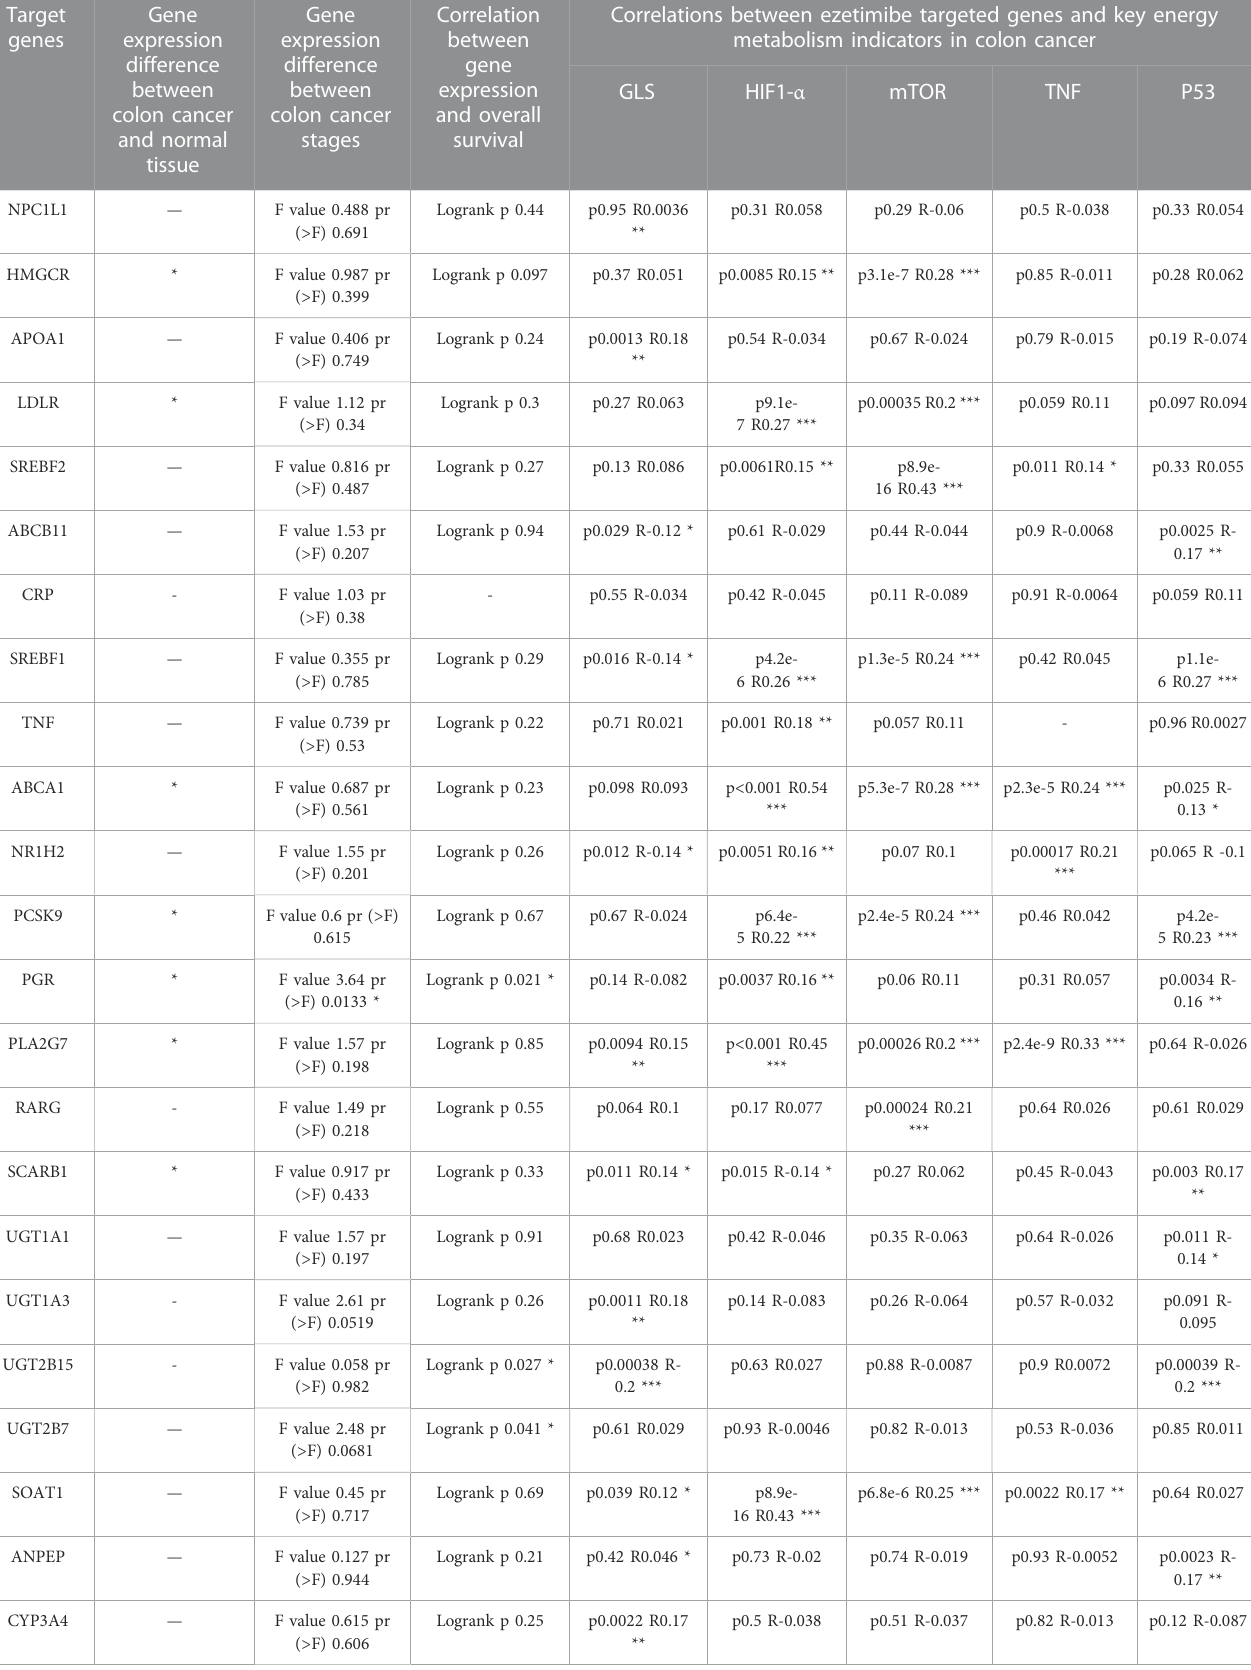
TABLE 1 Clinical features and correlations to GLS, HIF1- α , mTOR, TNF, p53 for the 29 ezetimibe targeted genes marked by the Comparative Toxicogenomics Database and